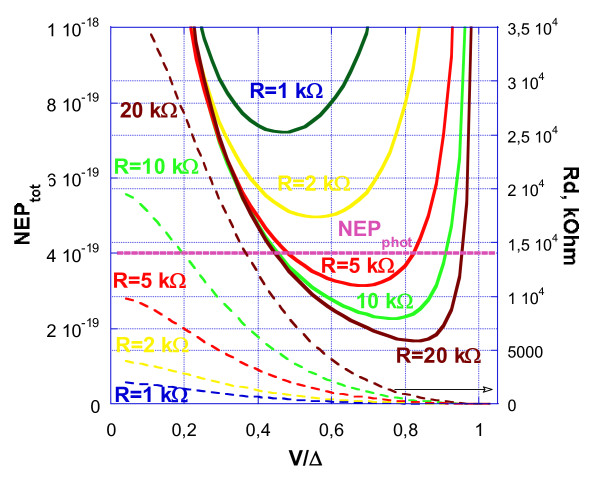
The NEP components of the 2D array of CEBs. NEP components of the 2D array of CEBs with JFET readout at 7 THz and a power load of 0.02 fW. Here, IJFET = 5 fA Hz-1/2, VJFET = 3 nV Hz-1/2, Λ = 0.002 μm3, T = 70 mK, and Tc = 400 mK for different values of normal resistance R.